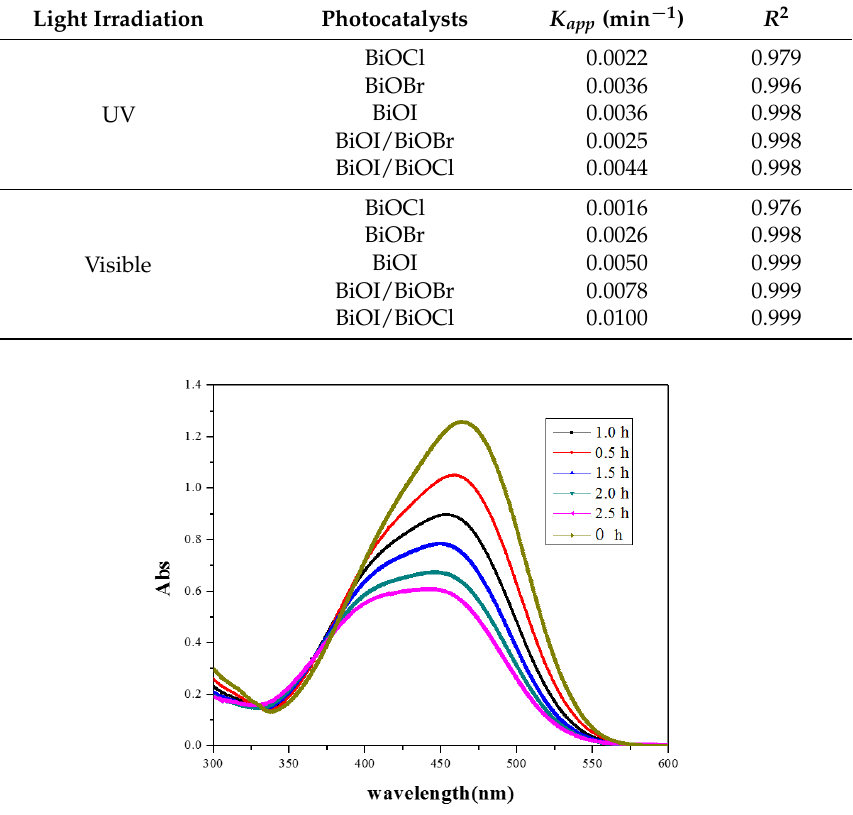
Figure 10. Temporal evolution of the spectra during the photodegradation of MO mediated by BiOI/BiOCl composite.